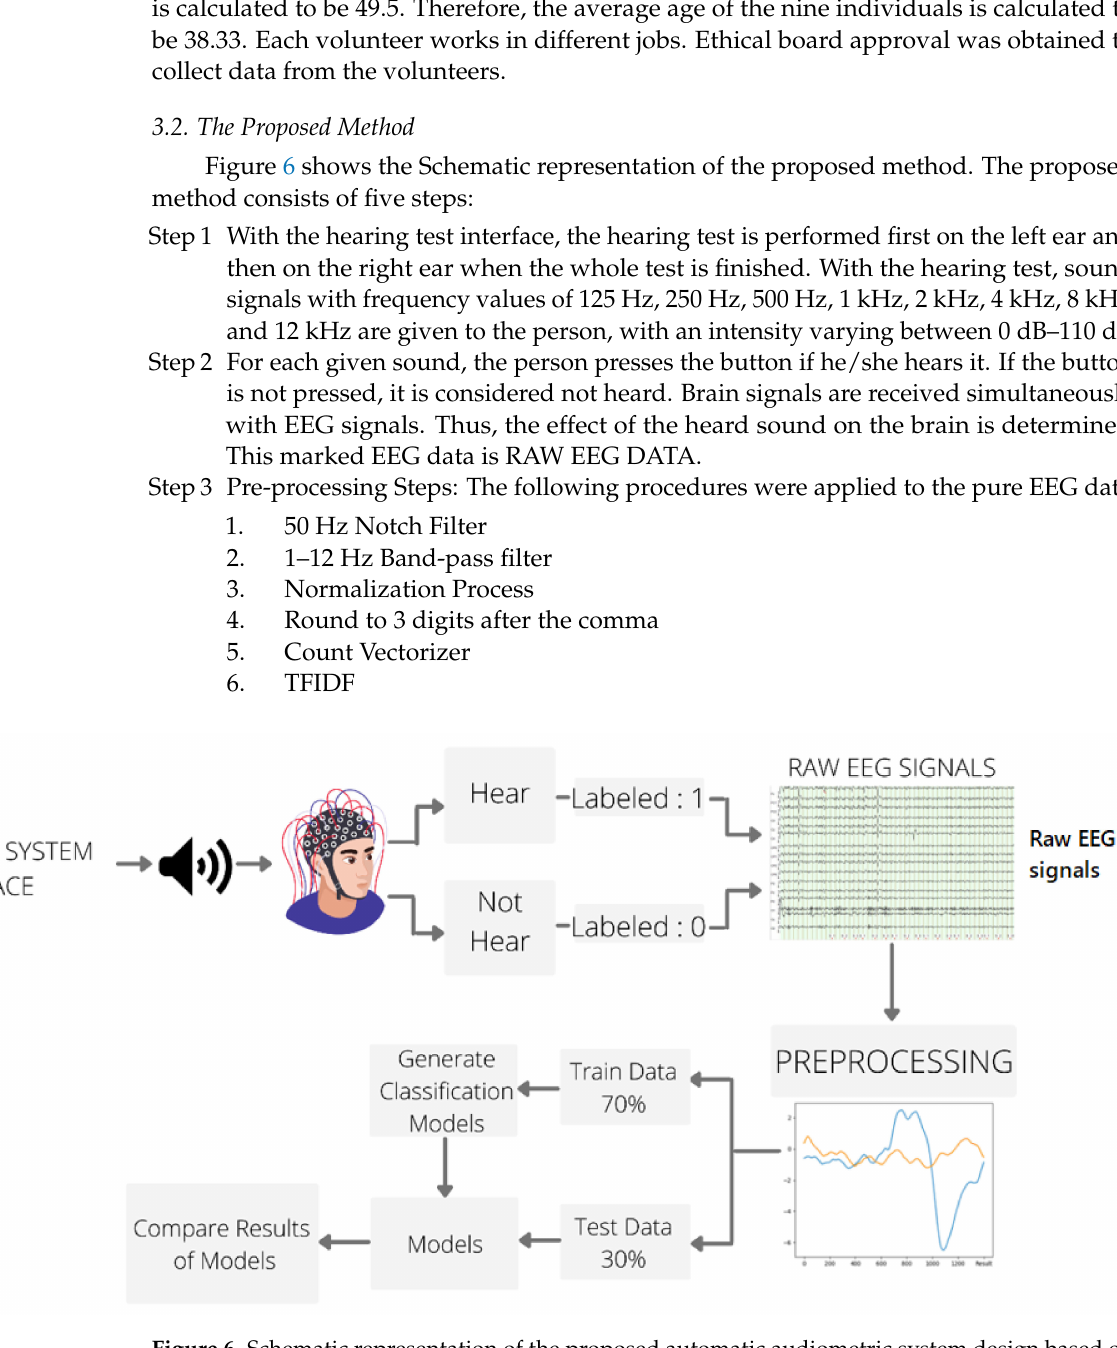
Figure 6. Schematic representation of the proposed automatic audiometric system design based on Machine Learning Methods using the EEG